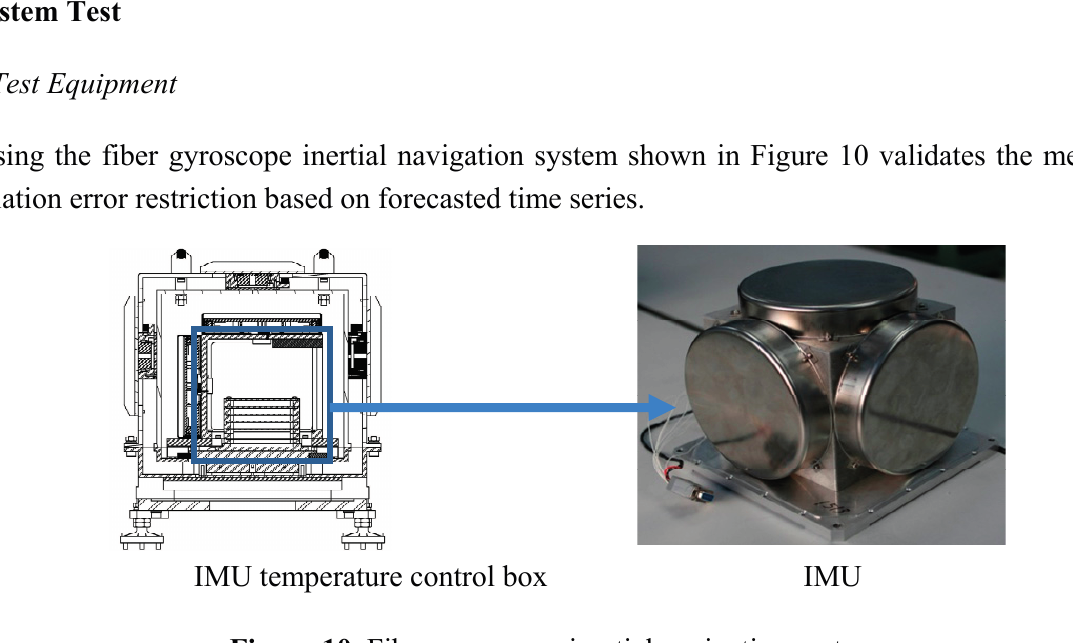
Figure 10. Fiber gyroscope inertial navigation system.